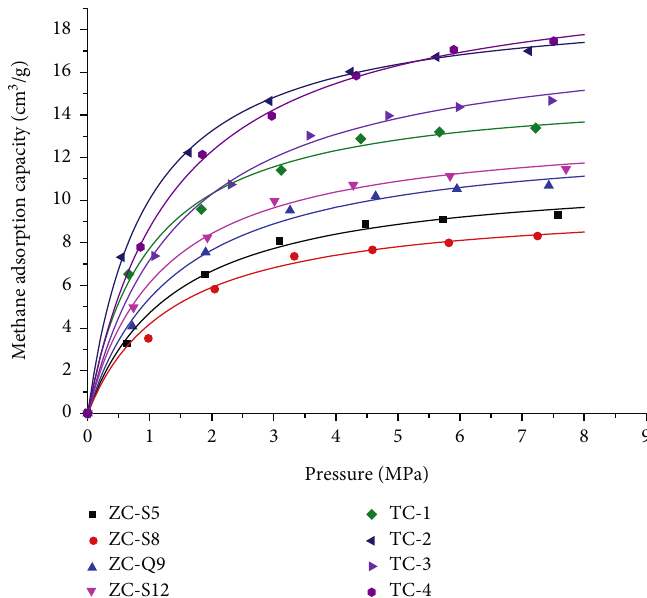
Figure 8: Methane adsorption isotherms of the coal samples.